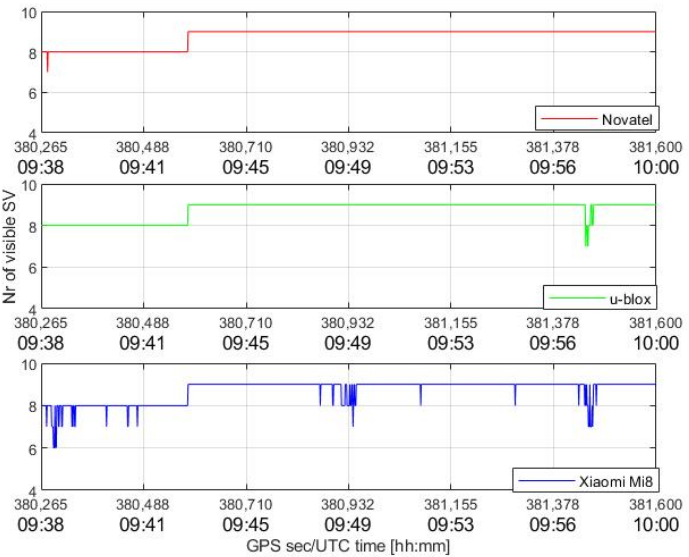
Figure 5. Satellite visibility for each device.